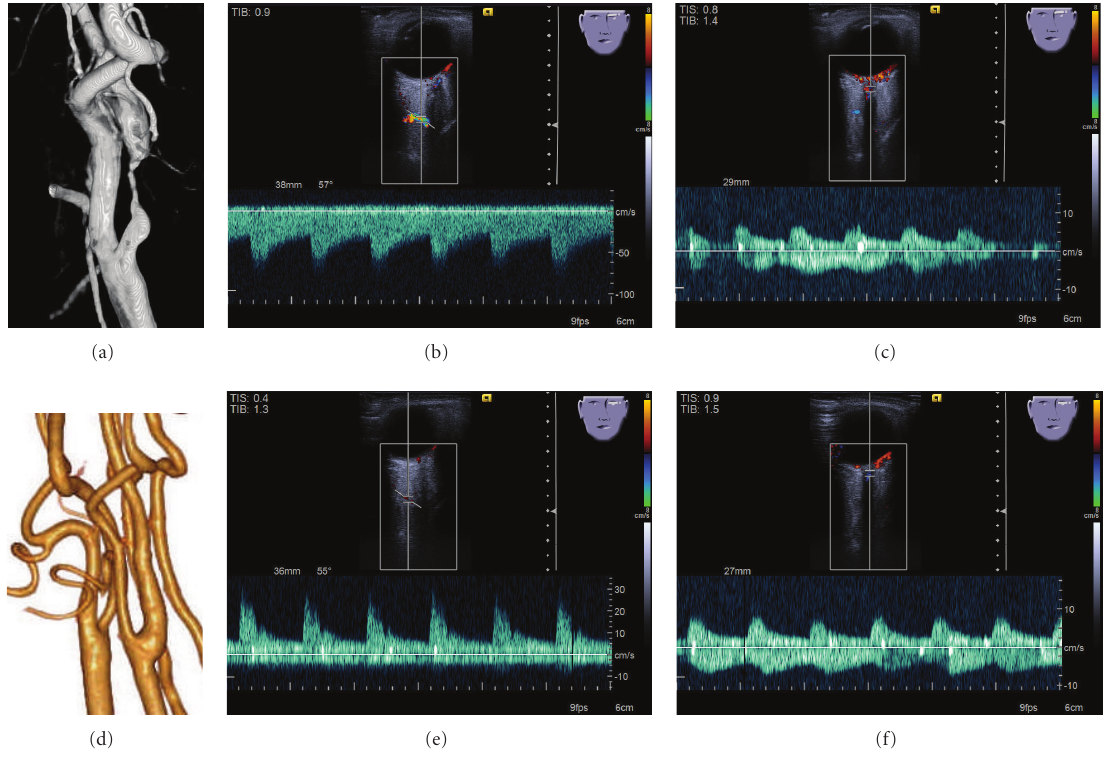
Figure 2: Left carotid angiography (a), ophthalmic artery Doppler flow imaging (b), and central retinal artery Doppler flow imaging (c) before carotid endarterectomy were shown. 3D CT angiography (d), ophthalmic artery Doppler flow imaging (e), and central retinal artery Doppler flow imaging (f) after carotid endarterectomy were